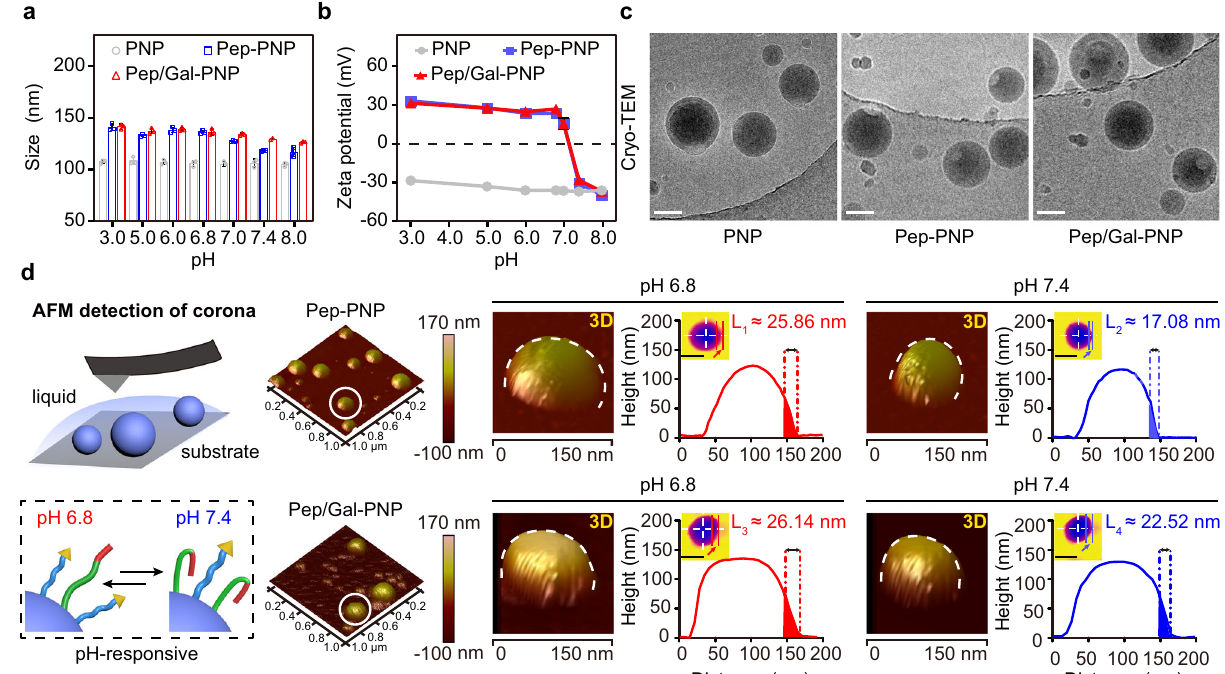
Fig. 3 | Synthesis and characterization of Pep/Gal-PNPs. a, b The size and zeta potentialofnanoparticlesunderdifferentpHconditions.Dataarepresentedasthe mean±SD ( n =3 biologically independent experiments). c Cryo-TEM images of nanoparticles. d Atomic force microscopy (AFM) analysis of nanoparticles under fl uidconditions.3Dmodelingimages,heightmaps,andheightpro fi lesofPep-PNPs